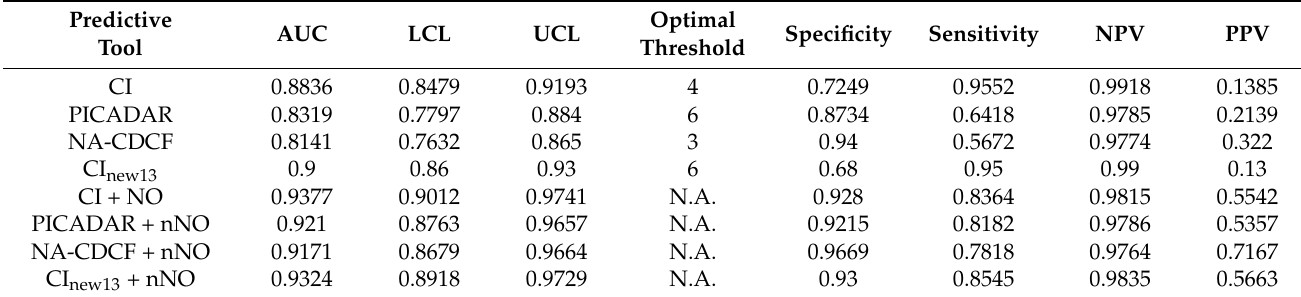
Table 4. Predictive characteristics of the individual tools—CI, PICADAR, NA-CDCF, and CI new13 without or with nNO measurements.